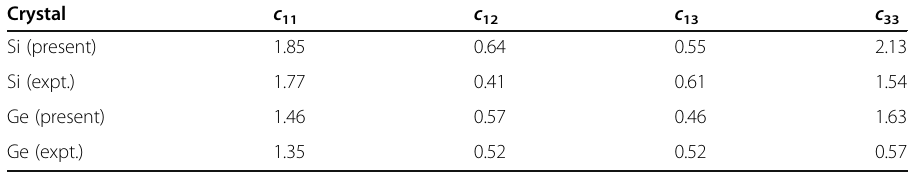
Table 2 Values elastic constants (× 10 − 11 N/m) for Si, Ge by present theory and experimental values [11] Crystal c 11 c 12 c 13 c 33 Si (present) 1.85 0.64 0.55 2.13 Si (expt.) 1.77 0.41 0.61 1.54 Ge (present) 1.46 0.57 0.46 1.63 Ge (expt.)